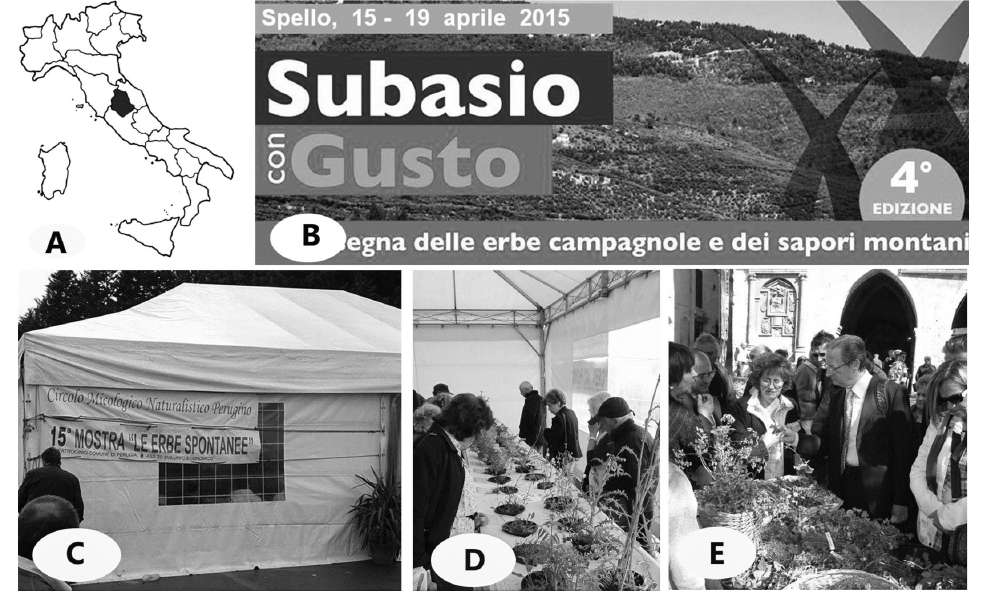
Fig. 1: Study area and some local events on edible wild plants in Umbria, Central